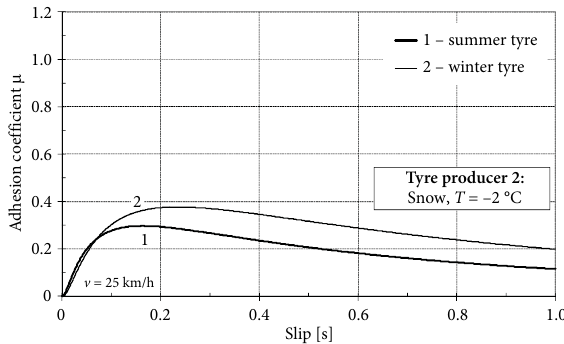
Figure 19. Adhesion characteristics m ( s ) for summer and winter tyres (snowy road surface, tyre producer Table 9. Differences in slip referring to m peak adhesion coefficient